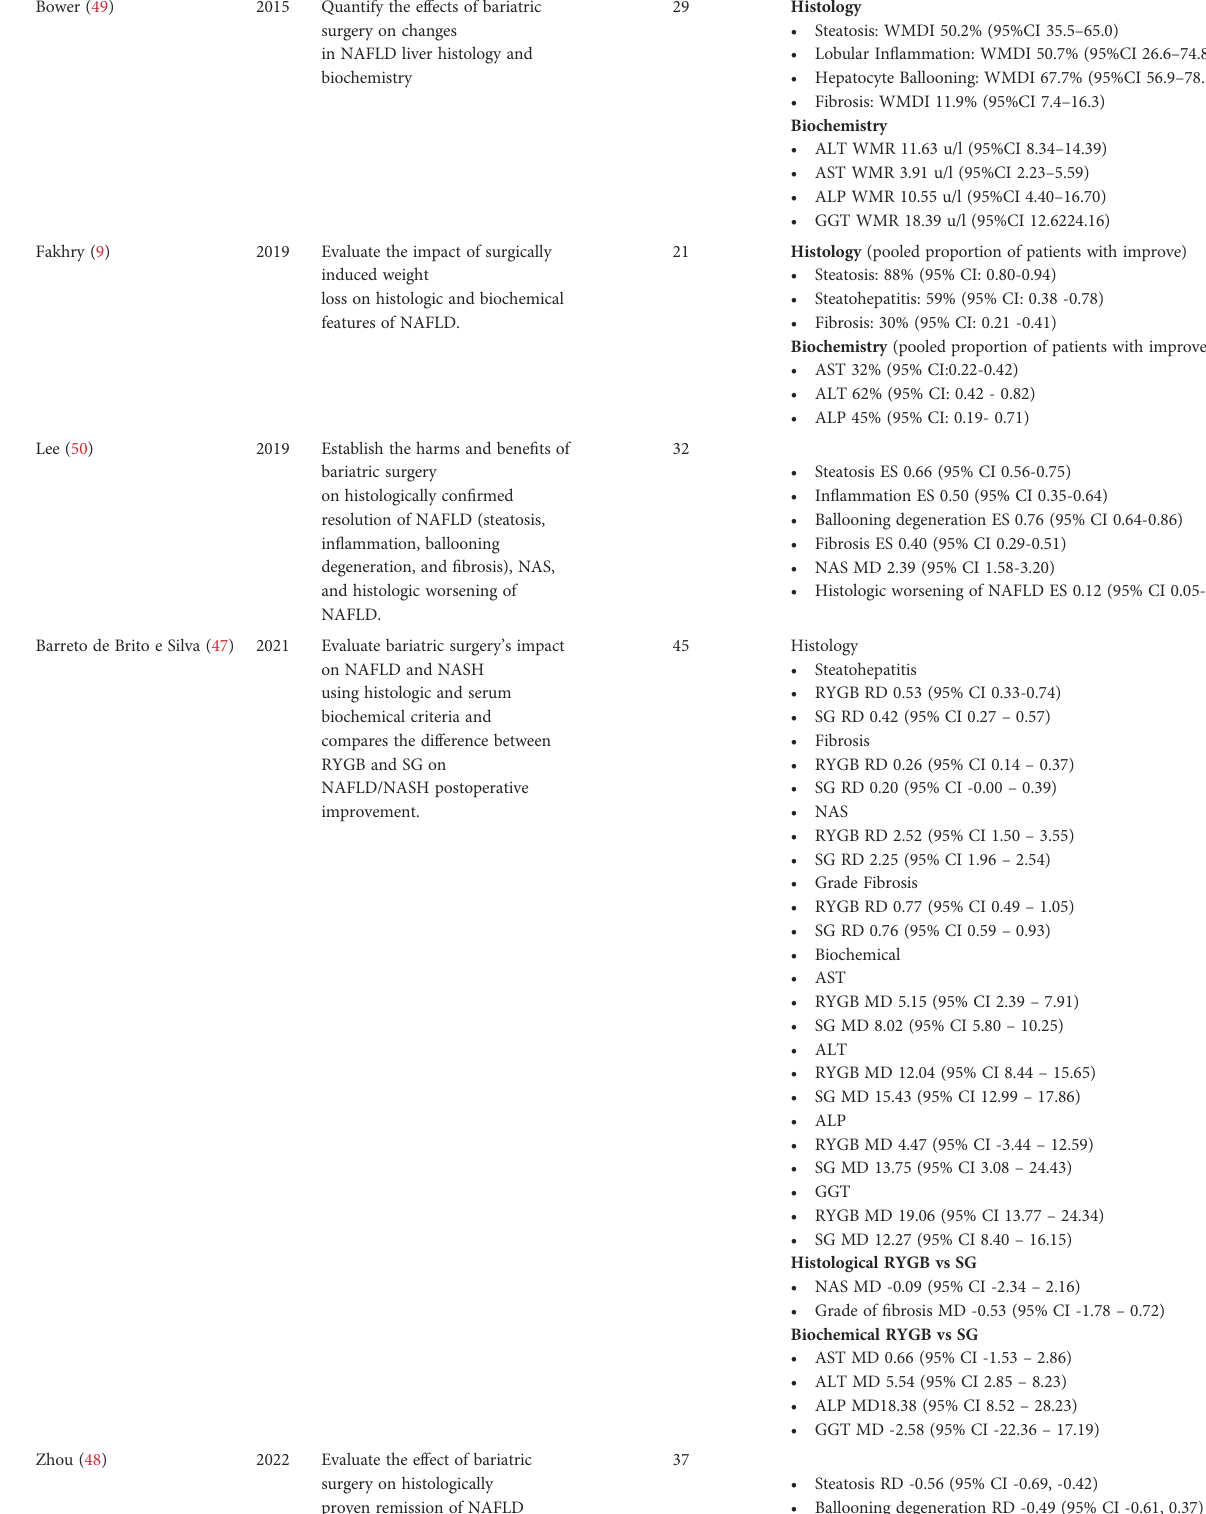
loss on histologic and biochemical features of